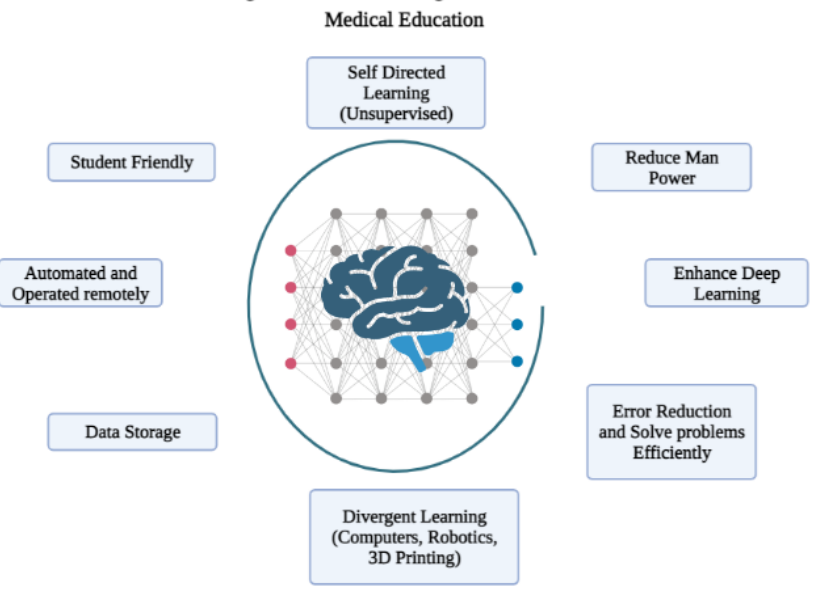
Figure 2. Advantages of artificial intelligence in the process of medical